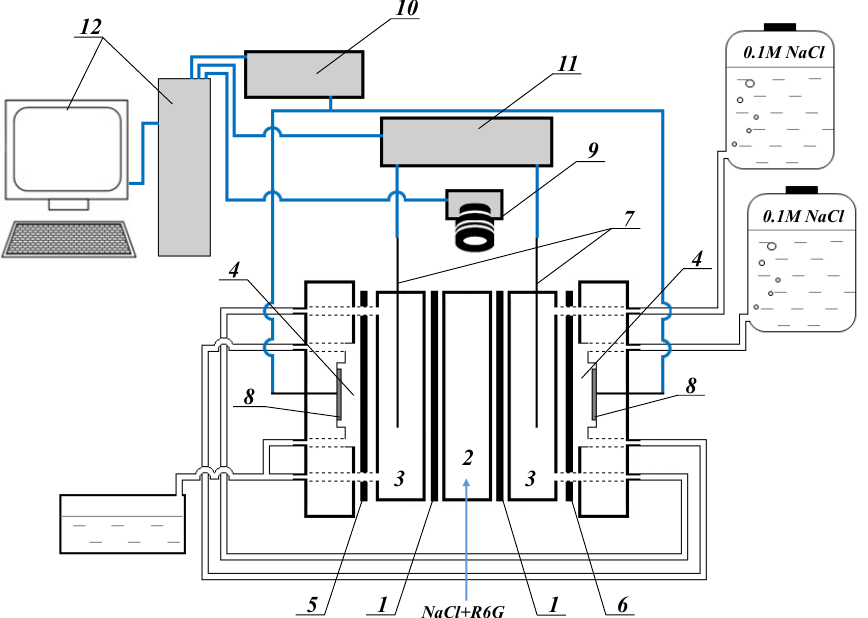
Figure 4. The scheme of an experimental setup for the visualization of vortex structures near anion- exchange membranes.